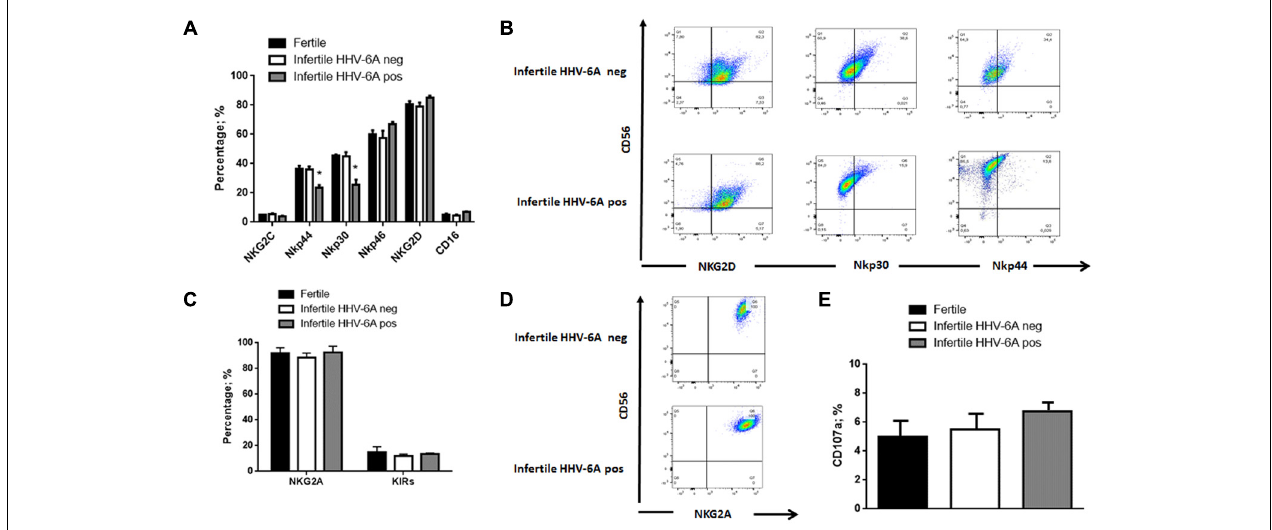
FIGURE 4 | eNK cell receptor repertoire expression. eNK cells purified from endometrial biopsies were stained for surface expression of the indicated (A) activating and (C) inhibitory receptors and (E) CD107a activation marker using fluorochrome-conjugated antibodies and analyzed by flow cytometry. (B,D) Representative FACS dot plots gated on CD56pos CD3neg dNK cells are reported. One representative dot plot out of five independent experiments is shown. ∗ Significant p -value obtained by Student’s t -test.